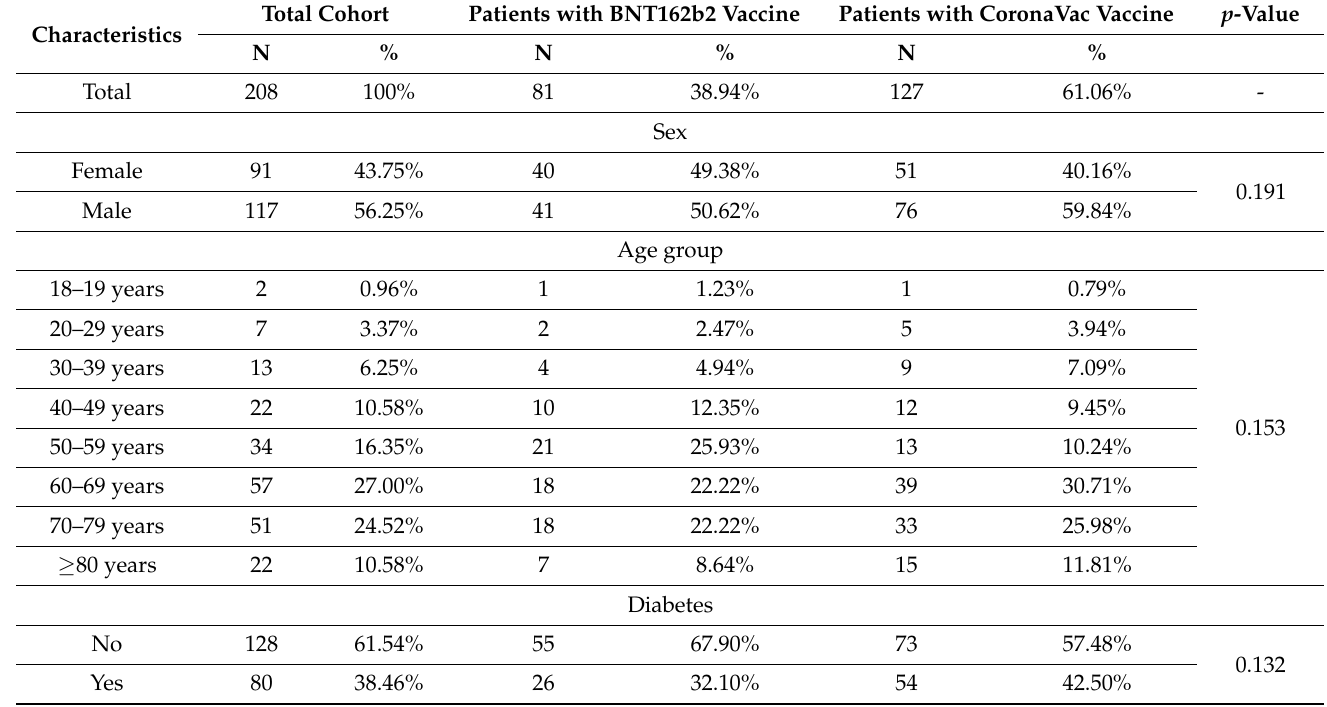
Table 1. Baseline patient characteristics. Data of the total cohort stratified by the vaccine used for the two-dose vaccination (BNT162b2 or CoronaVac) are detailed. Data are expressed as numbers (N)